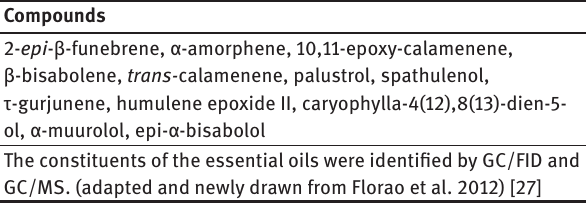
Table 3: Major components of the essential oils of B . articulata , B. dracunculifolia and B.